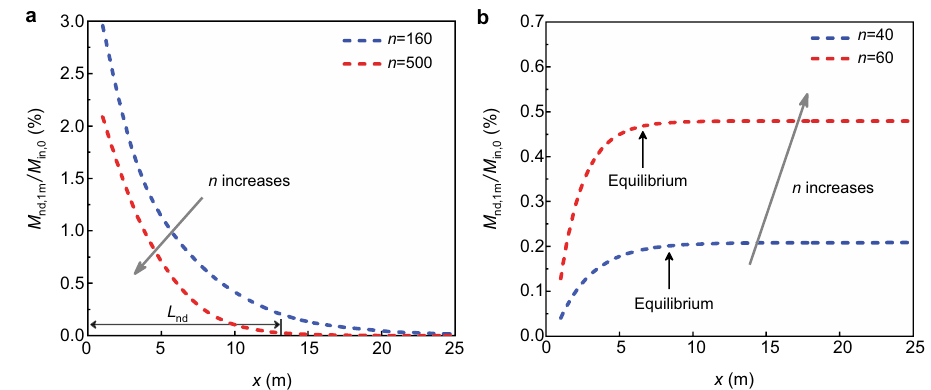
Fig. 4 | Two spatial patterns of sedimentation. a Pattern 1. In cases without resuspension ( τ n < τ c,n e.g., base cases n =160 and 500m − 2 ) normalized sedi- mentation M nd ,1m / M in ,0 , estimated over Δ x =1 m increments, decreases with dis- tance from marsh edge over deposition length-scale L nd , the maximum distance